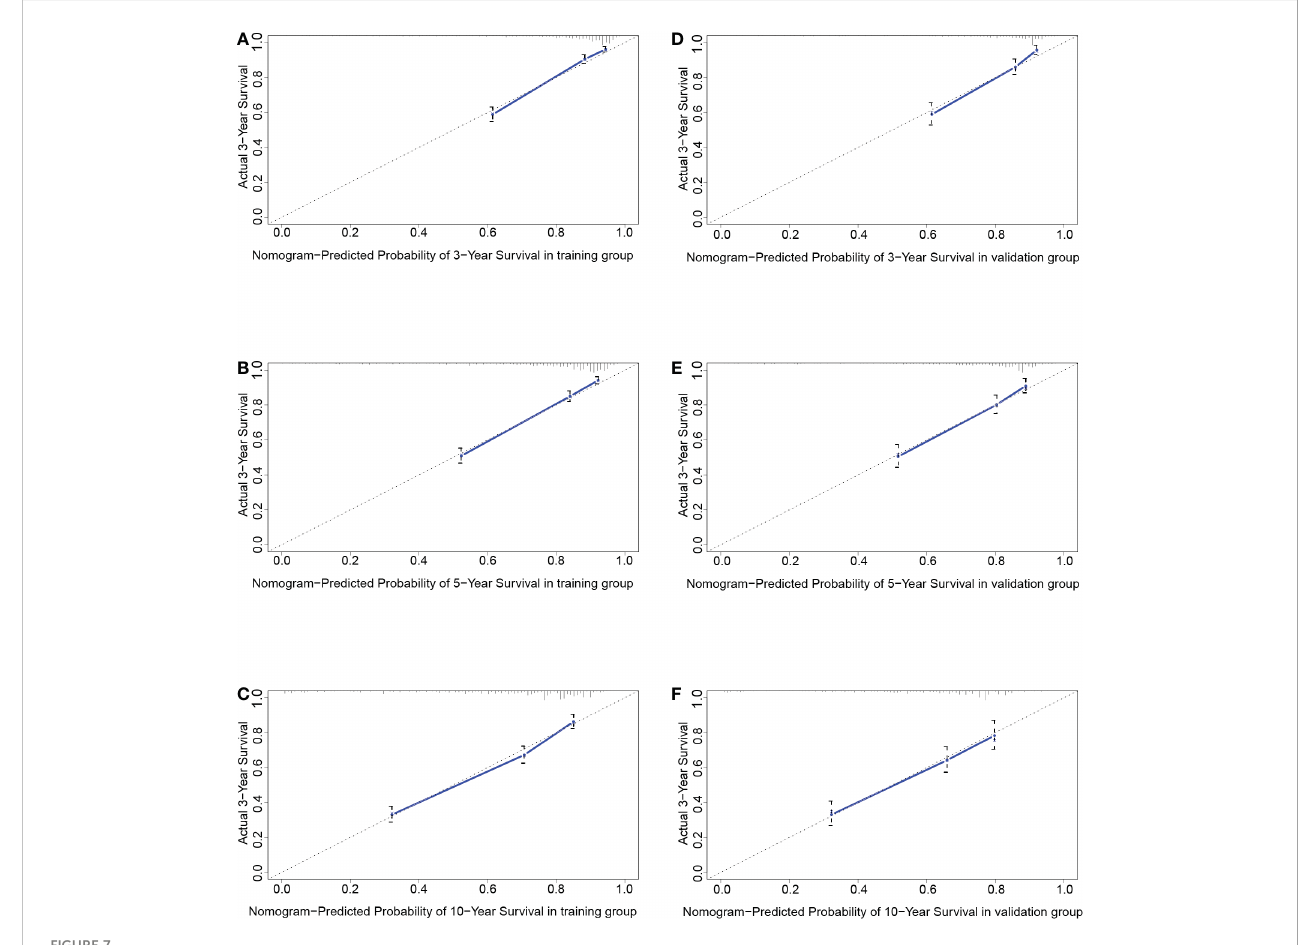
FIGURE 7 The calibration curves at 3 years (A) , 5 years (B) , and 10 years (C) in the training group and validation group (D – F)